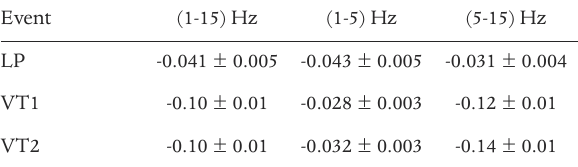
Table 1. Slopes and associated errors obtained for the EW compo- nent of BKE station.